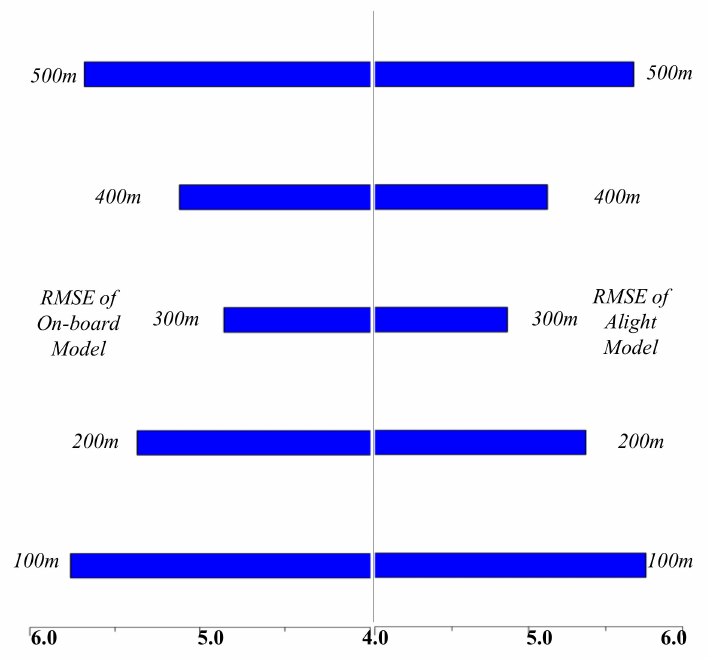
Figure 8. The RMSE and distance of the best service radius configuration part in the HRPFP model for line